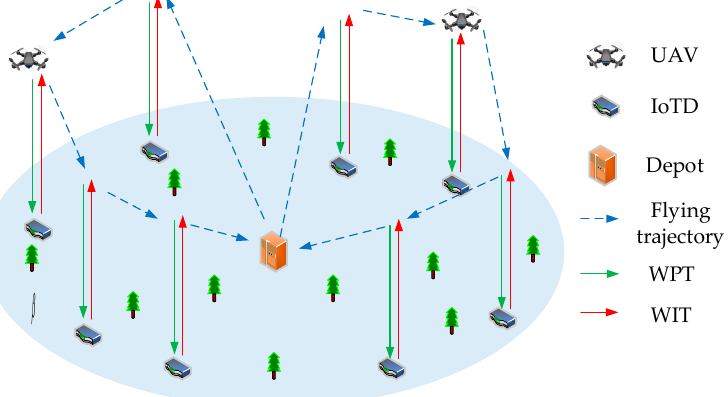
Figure 1. Illustration of multi-UAV aided wireless power and information transfer.